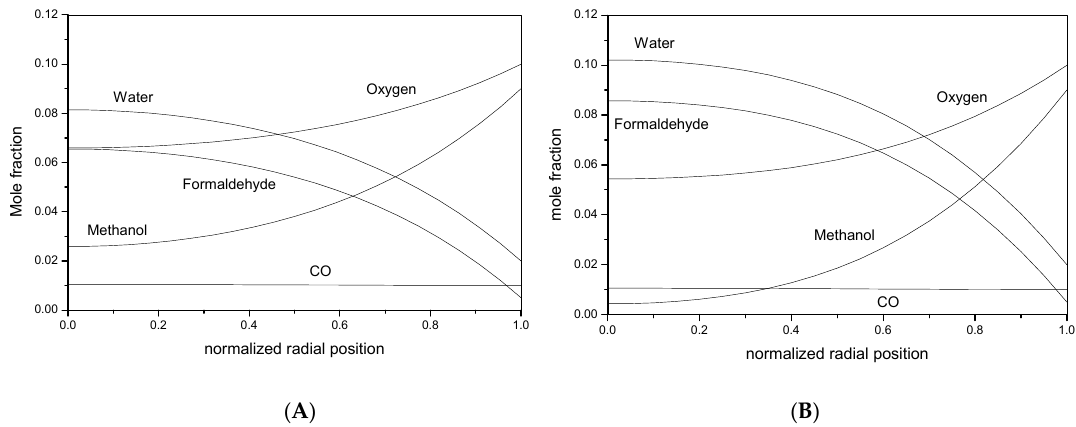
Figure 9. Mole fraction profiles inside a catalytic particle. ( A ) Kinetics of Riggs [30]; ( B ) kinetics of Dente et al. [28].